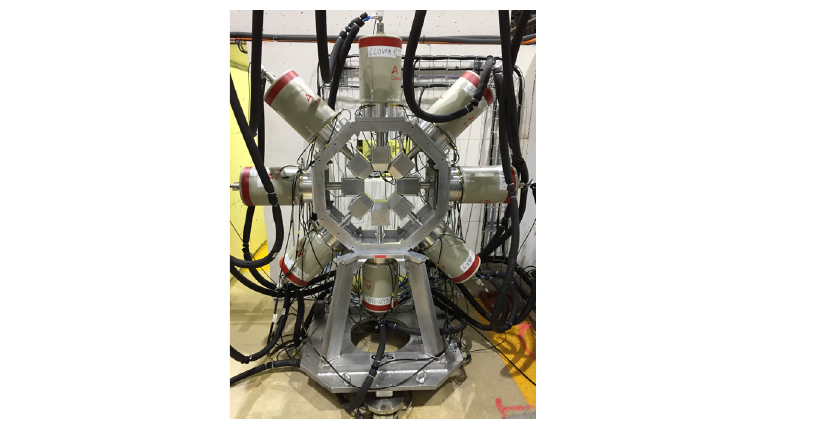
Figure 2: Arrangement of the 8 HPGe clovers of FIPPS phase 1 around the target position as used for the first FIPPS campaign. The di ff erent detectors are connected to the LN2 automatic filling system.